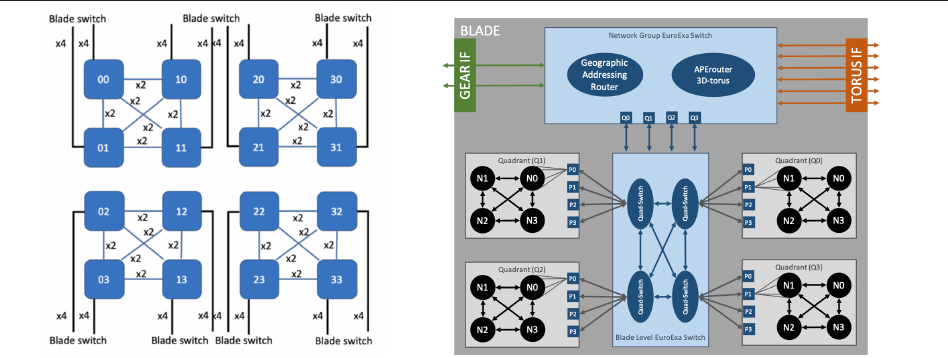
Figure 3. The EuroEXA TB2 Blade block diagram.